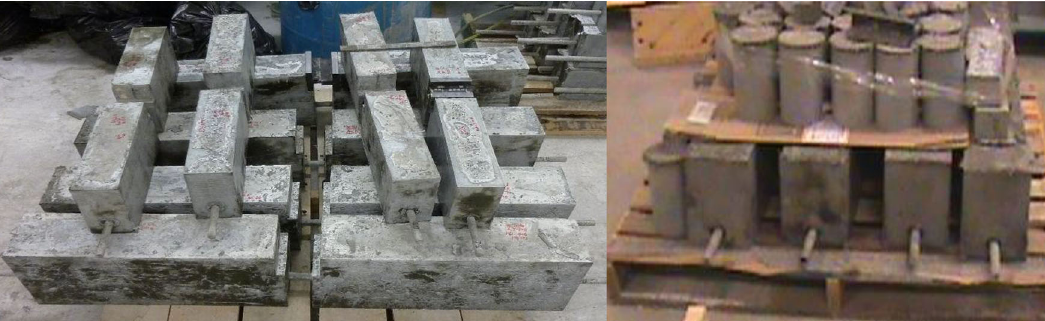
Fig. 5 Beam specimens with control cylinders.